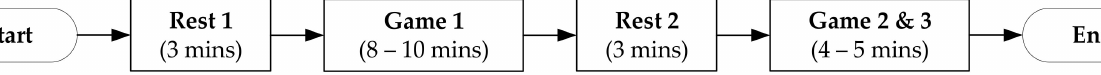
Figure 1. Experiment flow.